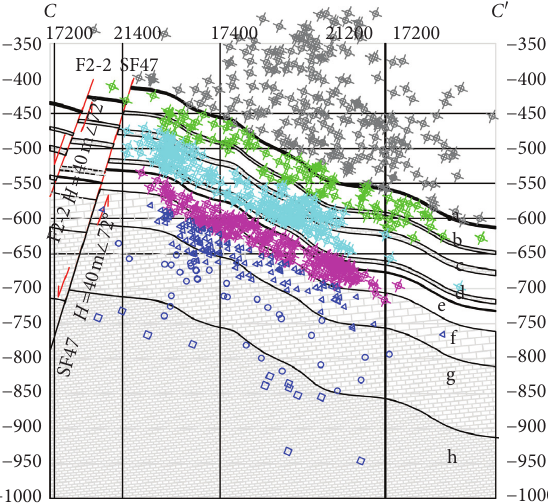
Figure 14: Distribution profile of microseismic events in May. a: 2# coal seam; b: Yeqing limestone; c: Shanfuqing limestone; d: Daqing limestone; e: 9# coal seam; f: Ordovician limestone; g: Ordovician limestone (50m); h: Ordovician limestone